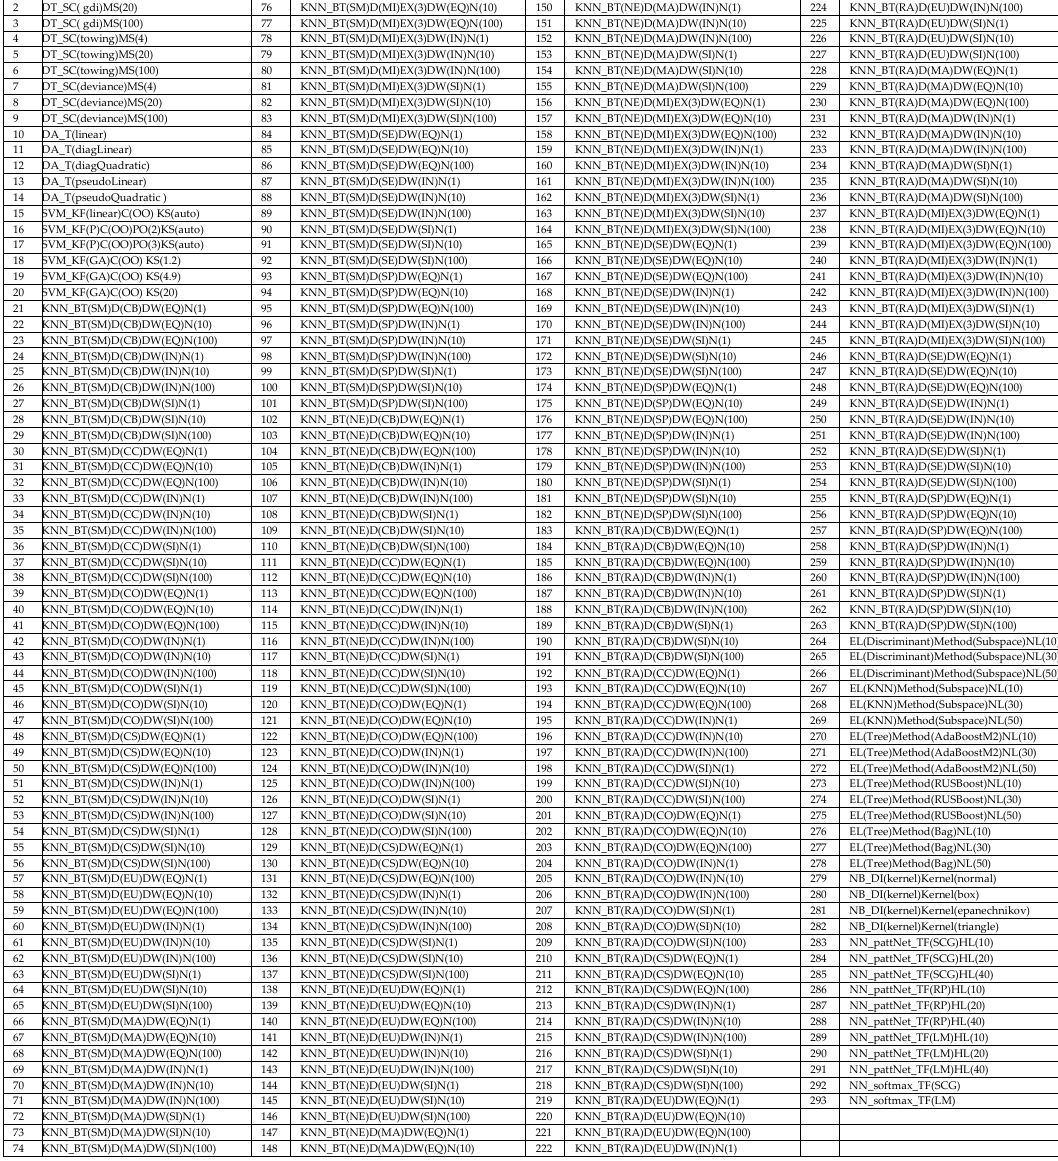
Figure A1. The list of the classifiers we explored in this paper. The numbers indicate the classifiers IDs.